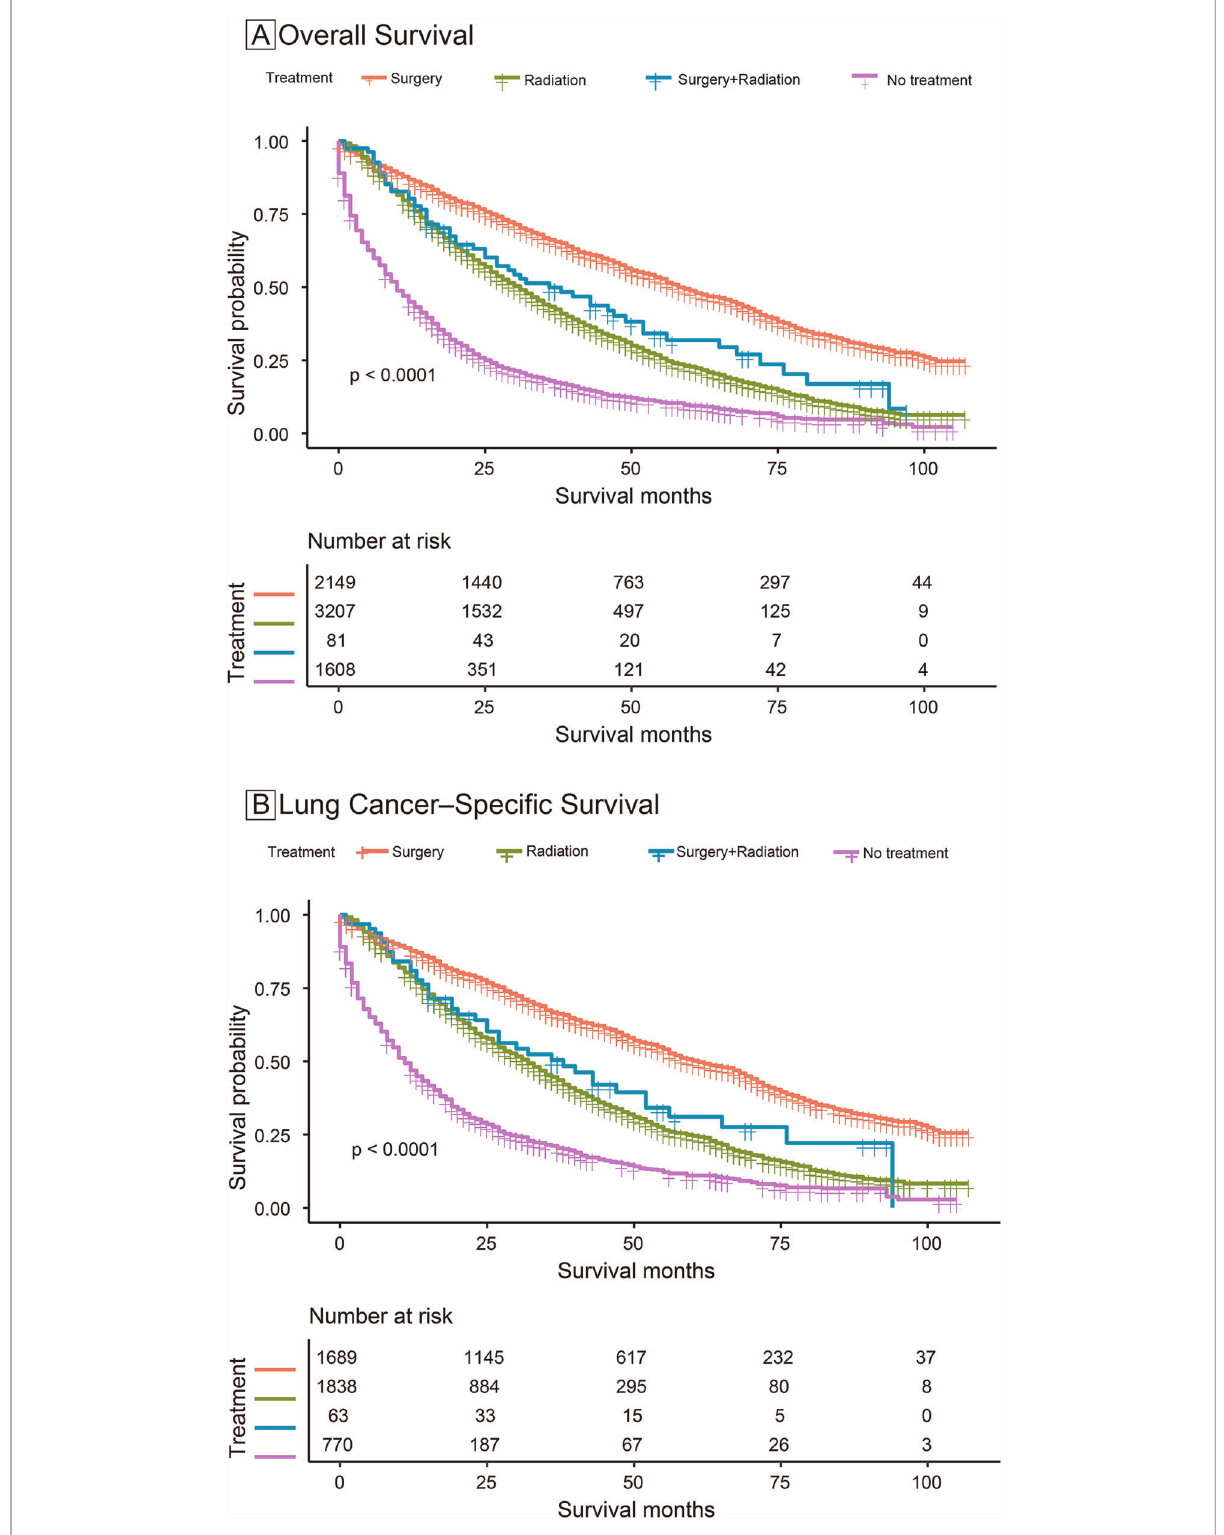
FIGURE 2 Survival strati fi ed by treatment modalities among patients ≥ 80 years old with NSCLC. ( A ) Overall survival; ( B ) Lung cancer-speci fi c